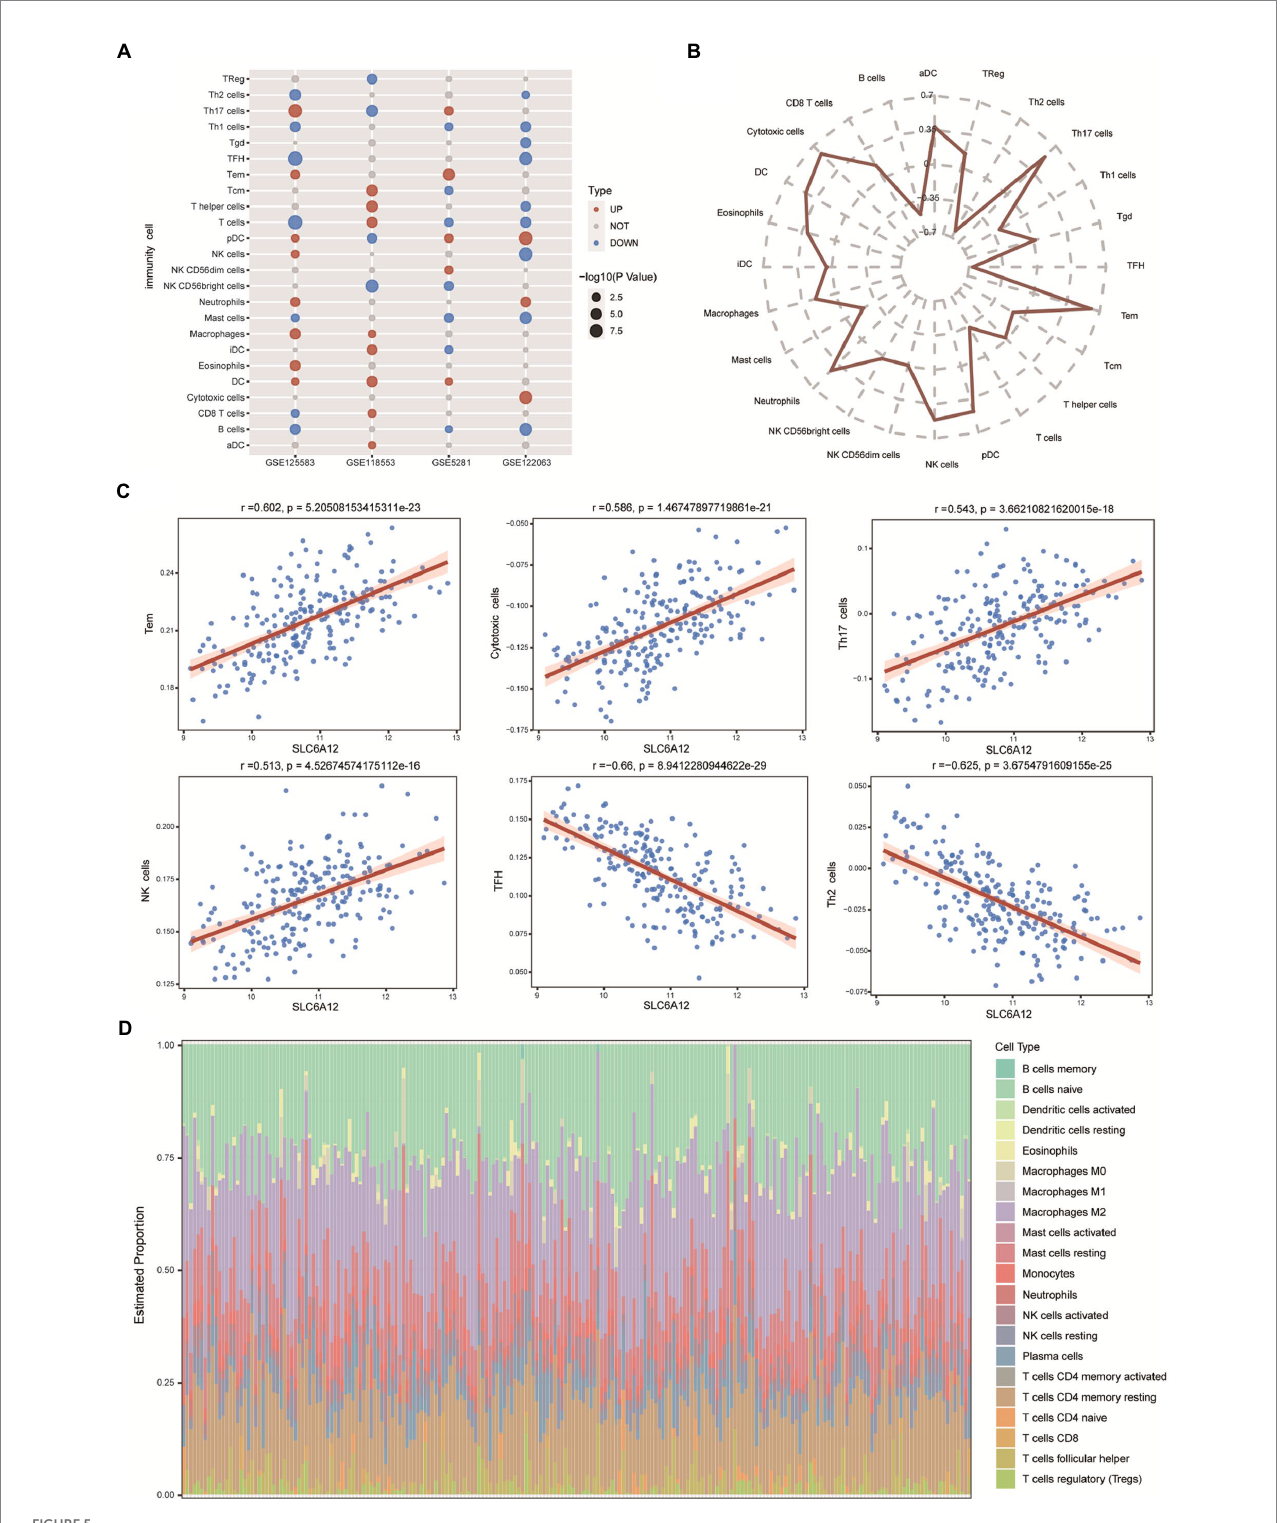
FIGURE 5 Infiltration of immune cells in Alzheimer’s disease (AD). (A) Infiltration of 24 immune cells in AD tissue based on expressed profiles in four datasets (GSE125583, GSE118553, GSE5281, and GSE122063). Red represents a high degree of infiltration, blue represents a low degree of infiltration. (B) Correlation between the feature genes and 24 immune cell types. (C) Correlation scatter plot displaying the hub gene and significantly positive and negative correlations. (D) CIBERSORT evaluation of the abundance of infiltration in